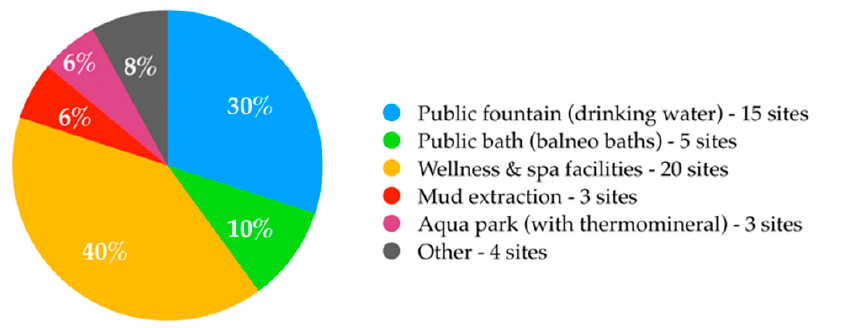
Figure 2. Proposed programs for new balneological sites in Vojvodina.